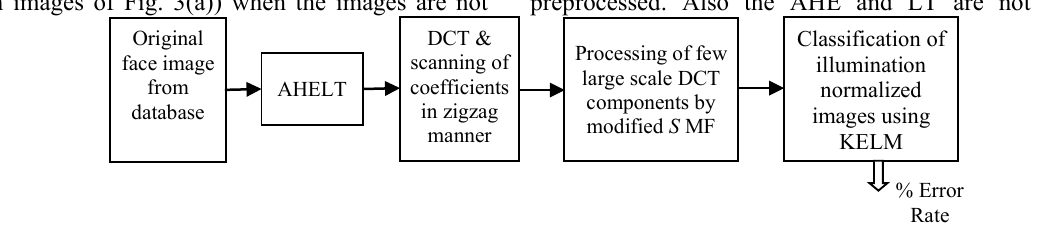
Figure 2. Block diagram of proposed approach of illumination normalization and